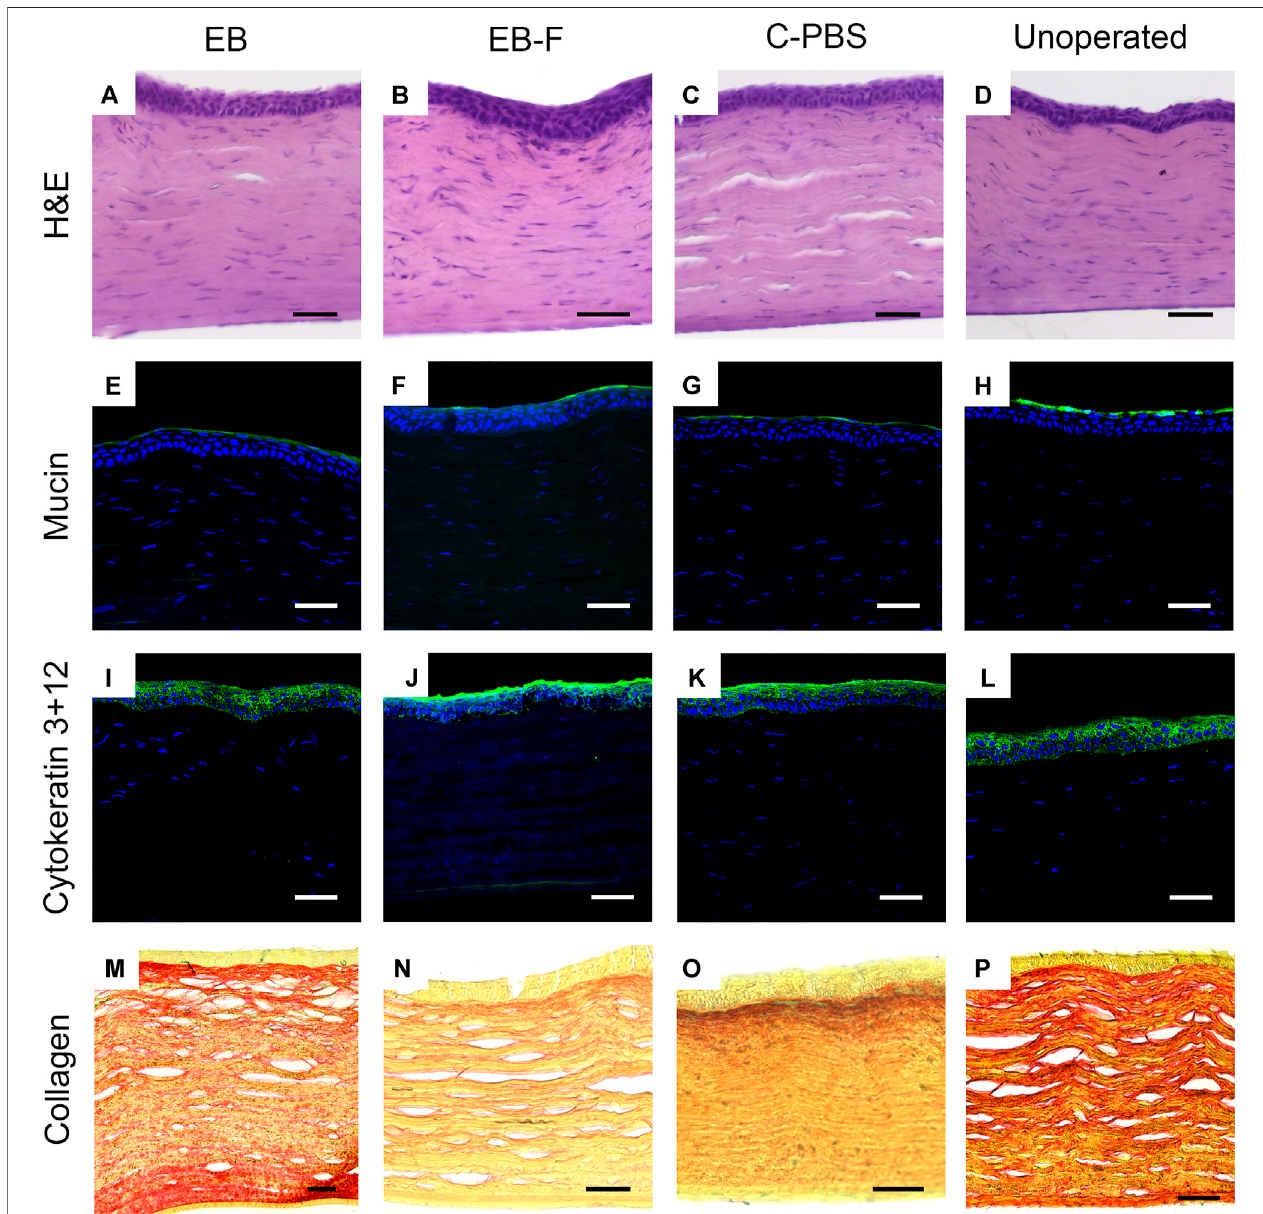
FIGURE 4 | Microscopy of representative sections from untreated corneas ( n = 12), e-beam irradiated corneas ( n = 4), e-beamed and frozen corneas ( n = 4) and C-PBS stored corneas ( n = 4). (A – D) Hematoxylin-eosin stained sections showing morphology of corneas with regenerated epithelia and stromas; endothelia and posterior stroma was untreated. (E – H) Ulex europaeus agglutinin staining showing a green fl uorescently labelled tear fi lm in all samples. (I – L) Cytokeratin 3 + 12 (green) staining of regenerated epithelia. (M – P) Picrosirius red-alcian blue stained samples showing red stained collagen fi brils arranged in lamellae in the stroma of all samples. White and black scale bars 50 μ m, yellow scale bars 25 μ